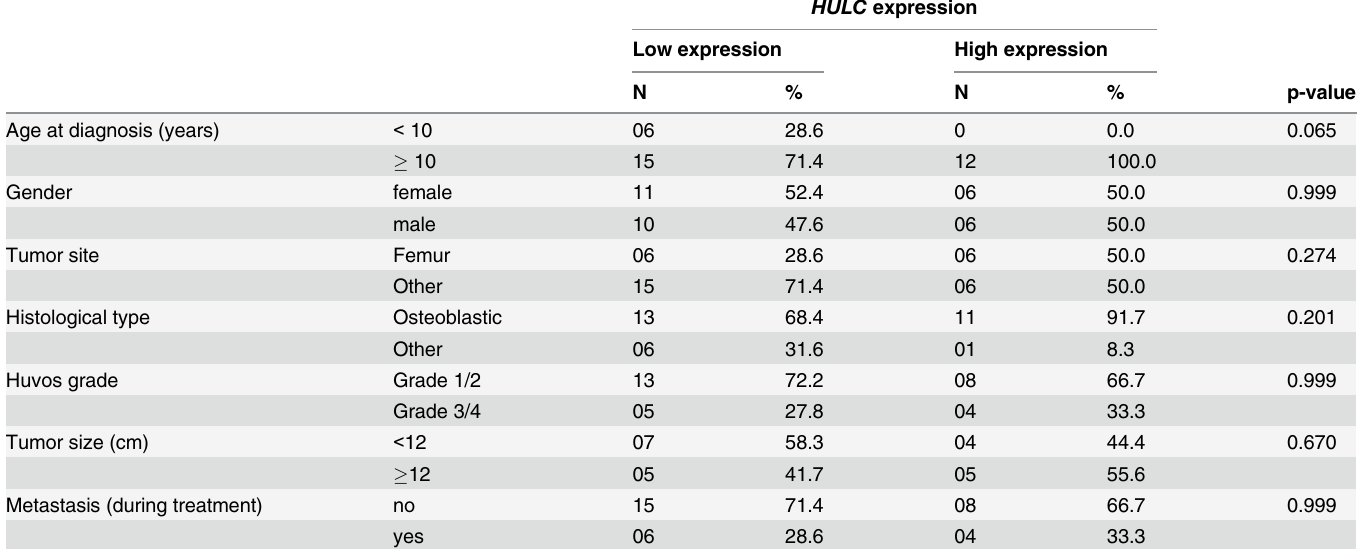
Table 3. Associations between HULC expression and clinicopathological characteristics of the OS patients.